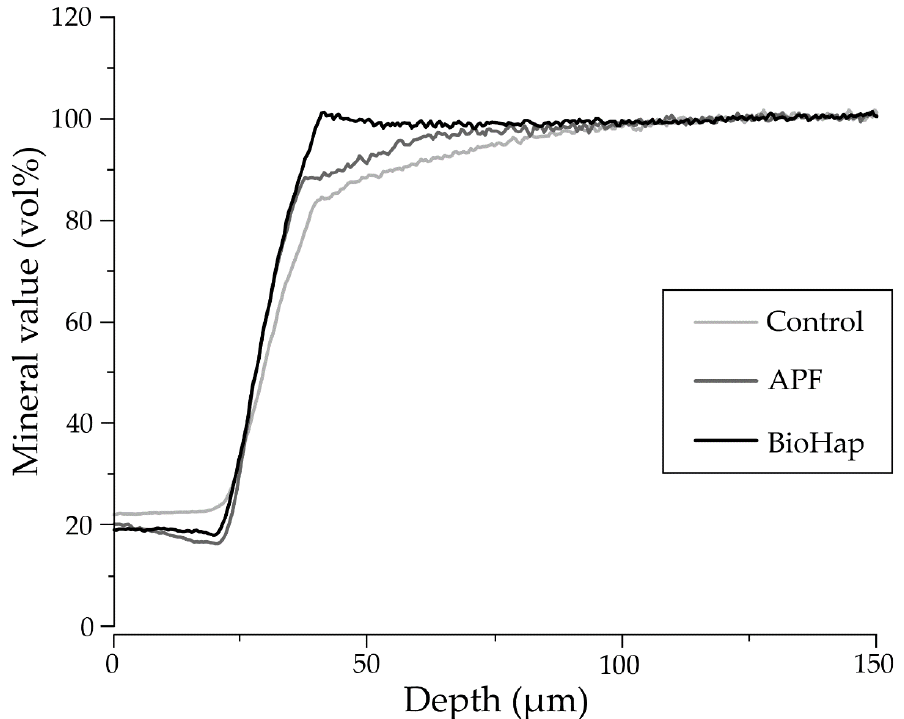
Figure 5. Graph of the mineral profile of preventive treatments for each group after the acid chal- lenge. The horizontal axis indicates the lesion depth, and the vertical axis shows the mineral value (vol%). As for the settings, the lesion depth demineralization start line is set to 25 μ m, and the min- eral value start line is set to 20–25